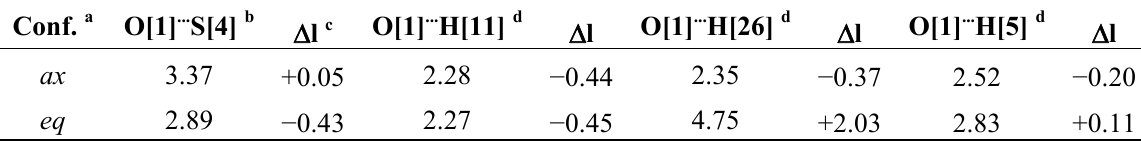
a Conformer designation; b Sum of the van der Waals radii = 3.32 Å; c Difference between non bonded atoms